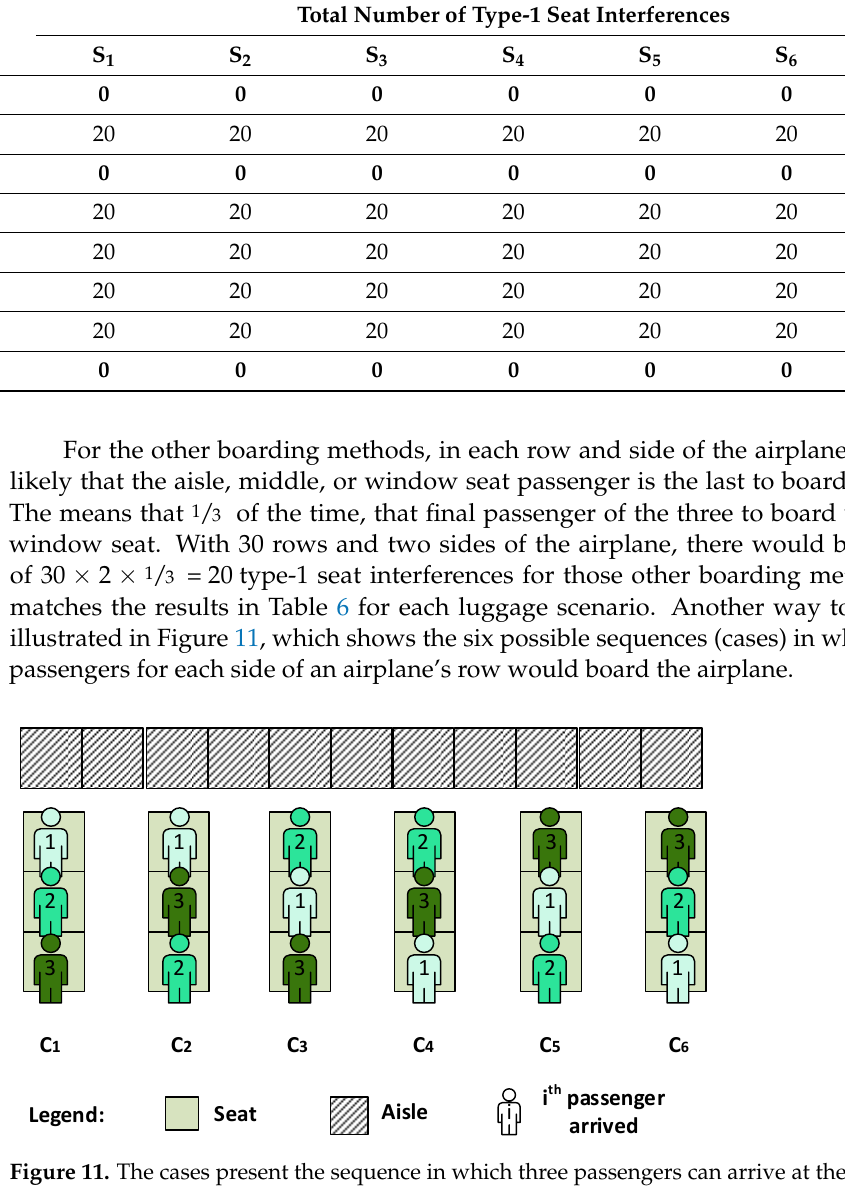
Figure 11. The cases present the sequence in which three passengers can arrive at their seats located on one side of the